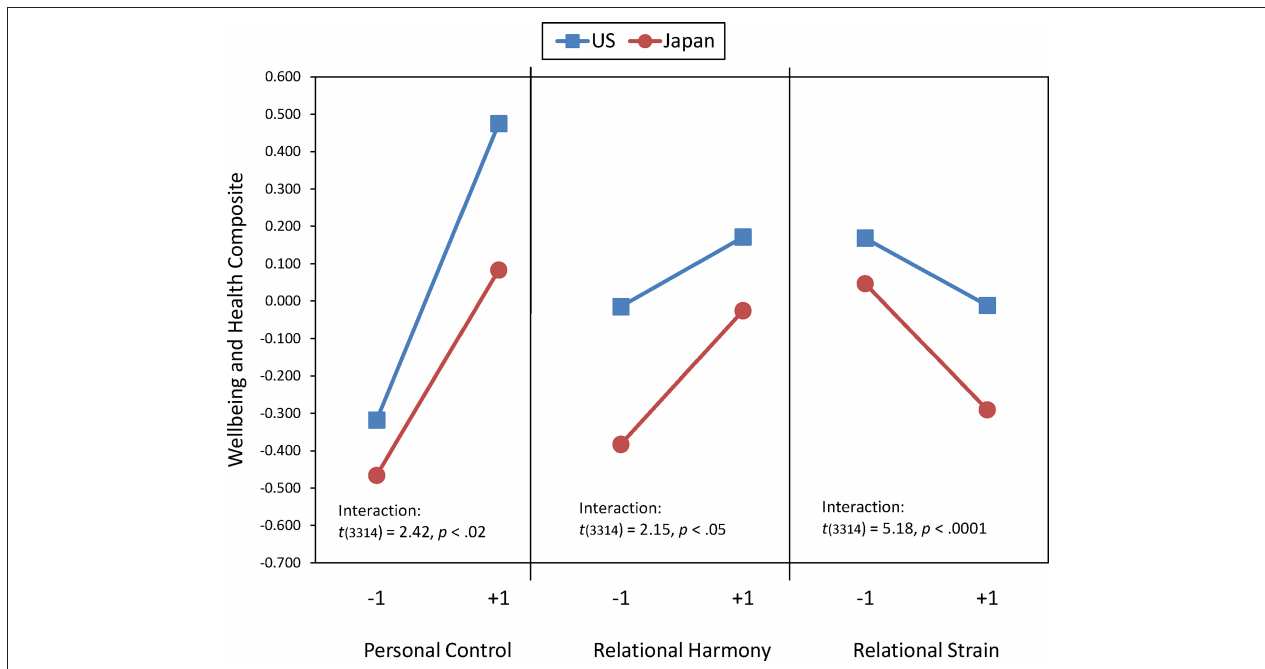
FigUre 2 | effects of personal control, relational harmony, and relational strain on the composite index of wellbeing and health in Japan and the United States. Estimated means for the wellbeing composite are plotted at 1 SD lower or higher than the mean level of each of the three independent variables within each